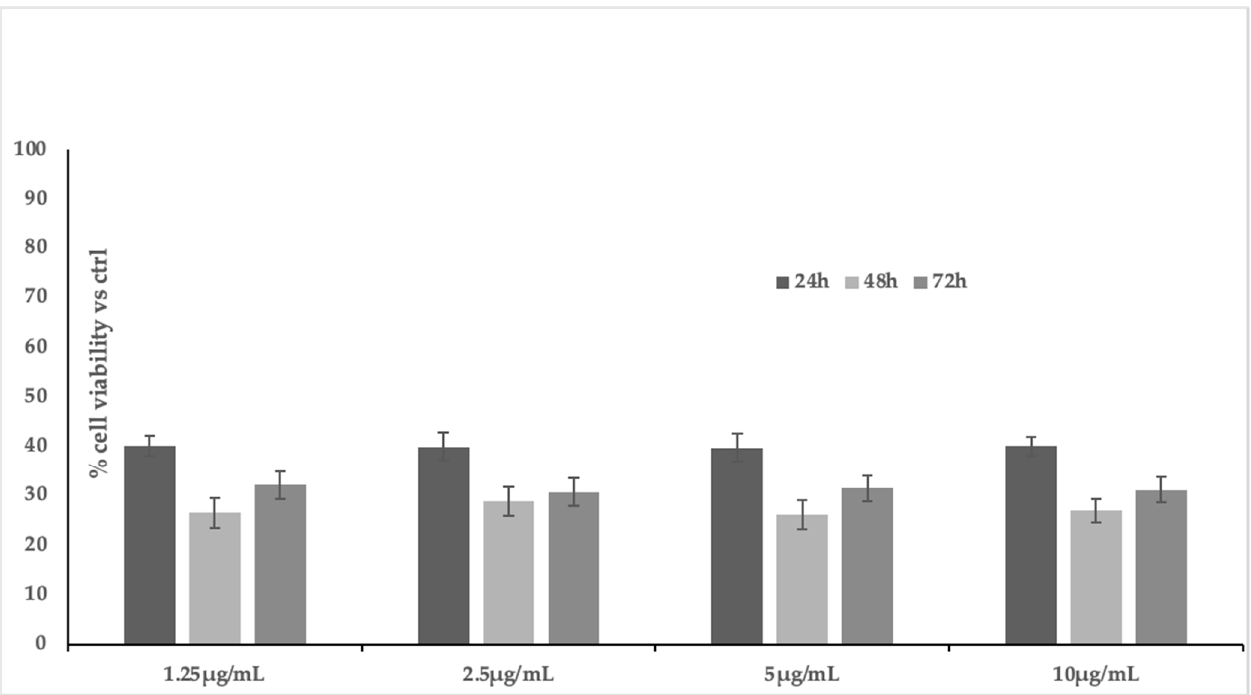
Figure 2. Evaluation of SKBR3 cell viability treated for 24, 48 and 72 h with different concentrations of EO obtained from Vepris macrophylla leaves. Cell viability was calculated considering the control value and standardized to 100%. Data represent mean ds (n = 3).